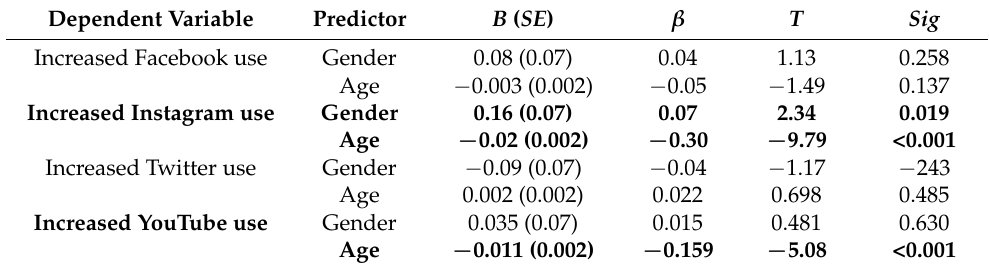
Table 3. Regression Equation Predicting the Increased Use of Facebook, Instagram, Twitter and YouTube.